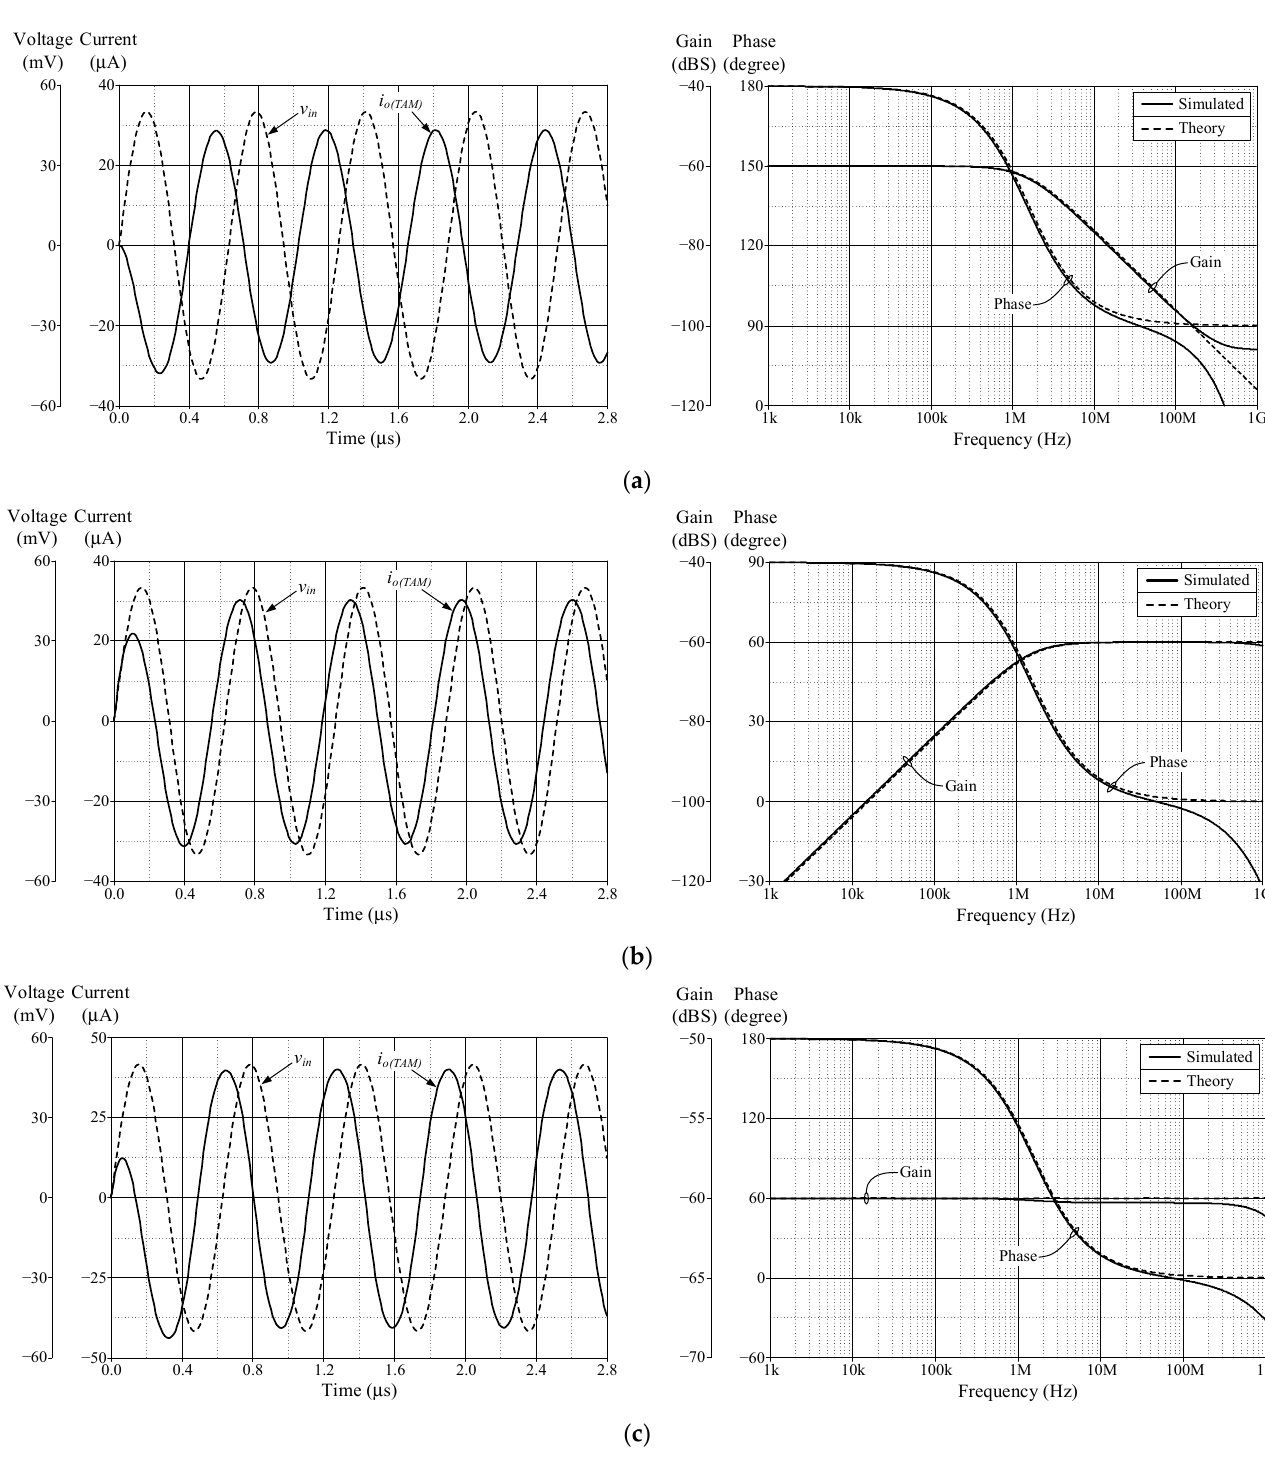
Figure 6. Simulated time and frequency responses of the proposed TAM filter: ( a ) LP; ( b ) HP; and ( c ) AP.